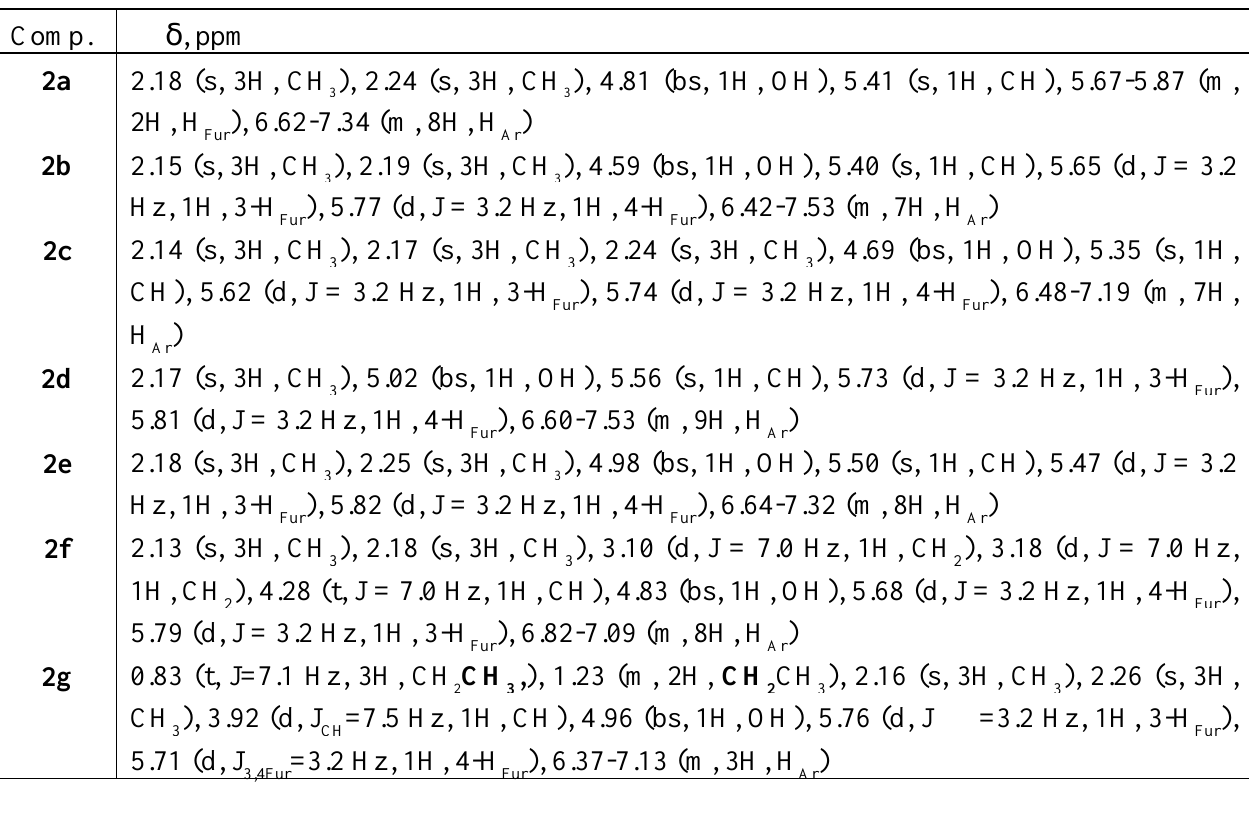
Table 2. 1 H-NMR spectra of compounds 2a - g